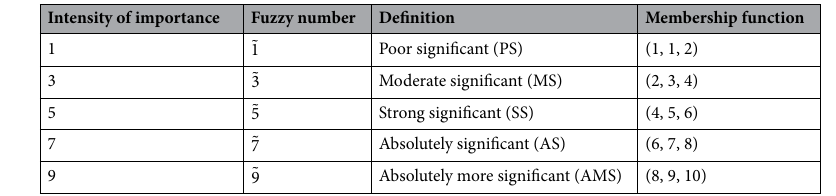
Table 1. TFN fuzzy scale.